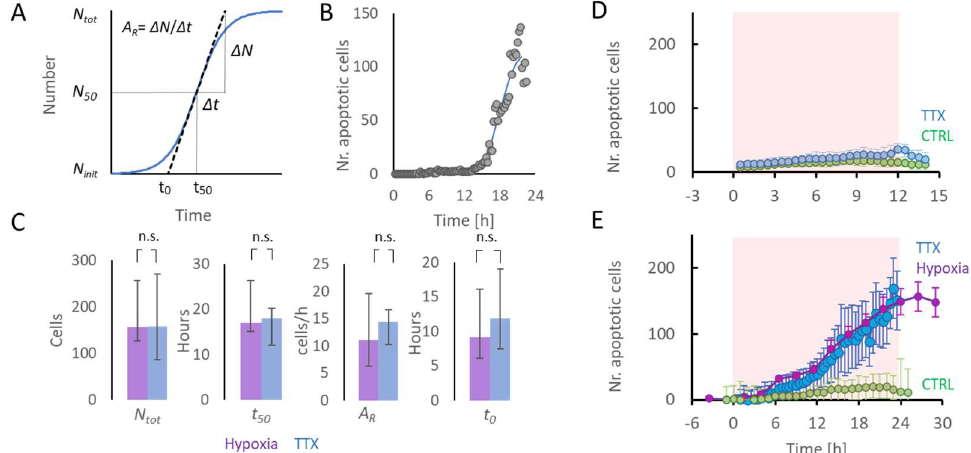
Figure 3. Temporal evolution of the number of apoptotic cells in cultures exposed to hypoxia (purple), TTX (blue), or control conditions (green). ( A ) A sigmoid function (Equation (1)) was fitted to the temporal evolution of the number of apoptotic cells to estimate the apoptotic rate ( A R ), the maximum number of apoptotic cells ( N tot ), and the time until 50% of N tot has been reached ( t 50 ). These parameters were used to estimate the time of onset of apoptosis, t 0 (Equation (2)). ( B ) Example of temporal evolution of number of apoptotic cells in a culture exposed to TTX for 24 h. ( C ) Median values of N tot , t 50 , and A R for cultures exposed to hypoxia ( n = 13, purple) or TTX (blue, n = 9) for 24 h. n.s.: not significant. Error bars represent 25–75% quartiles. ( D ) Averaged temporal evolution of apoptosis in cultures under control conditions (green; n = 4) or exposed to TTX (blue; n = 3) for 12 h. ( E ) Averaged temporal evolution of apoptosis in cultures under control conditions (green; n = 4), or exposed to TTX (blue; n = 11) or hypoxia (purple; n = 17) for 24 h. Error bars indicate SEM. Shaded orange background in ( D ) and ( E ) indicates exposure to TTX or hypoxia.